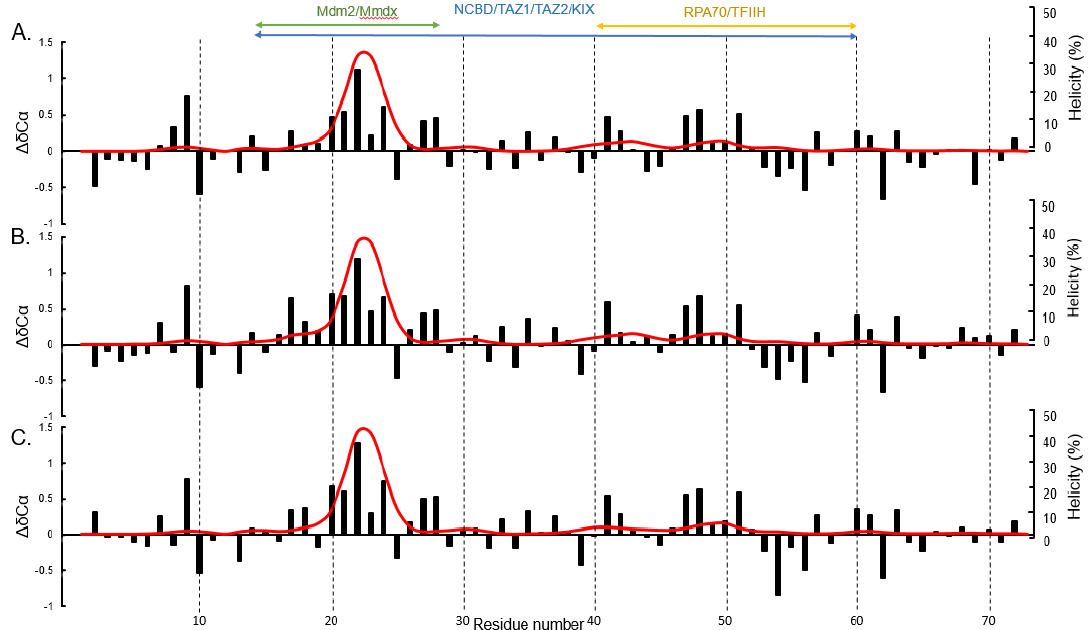
Figure 2. Residue specific secondary structure of p53TAD and phosphomimetics. Secondary chemical shift plots and δ2D plot for p53TAD and phosphomimetics determined from nuclear magnetic resonance (NMR) spectroscopy. ( A ) p53TAD ( B ) S15D ( C ) S15D/T18E. α-carbon secondary chemical shift (ΔδCα, black bars) and helical δ2D plots (red line) for the p53TAD and phosphomimetics as determined by NMR spectroscopy. Colored bars indicate binding sites for respective protein partners. The α-carbon chemical shifts for p53TAD was collected on a 600 MHz NMR at a digital resolution of 0.31 ppm. The alpha carbon chemical shifts for S15D and S15D/T18E was collected on an 800 MHz NMR at a digital resolution of 0.27 ppm.